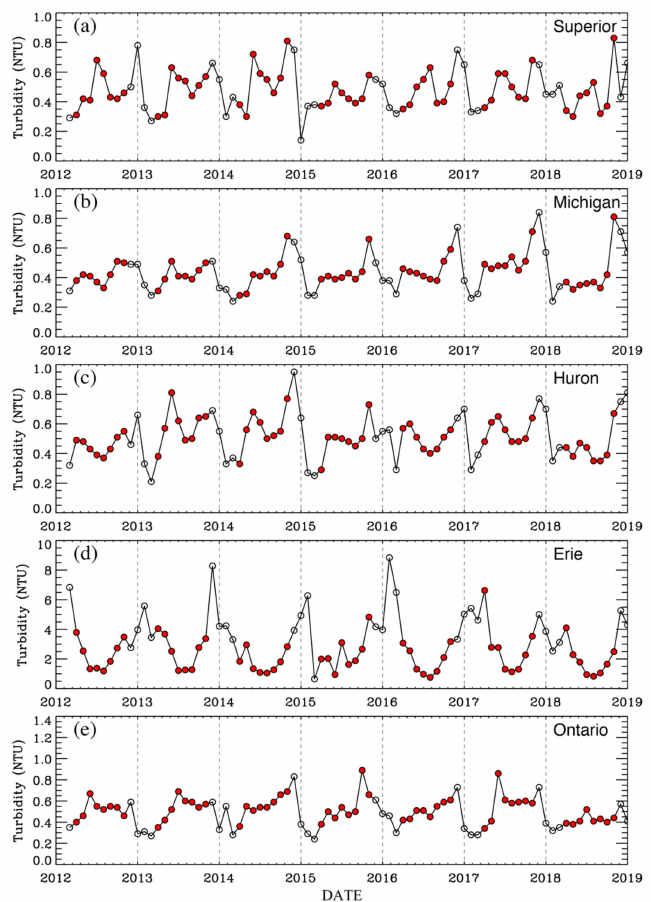
Figure 6. Time series of the VIIRS–SNPP-derived mean monthly water turbidity in the Great Lakes